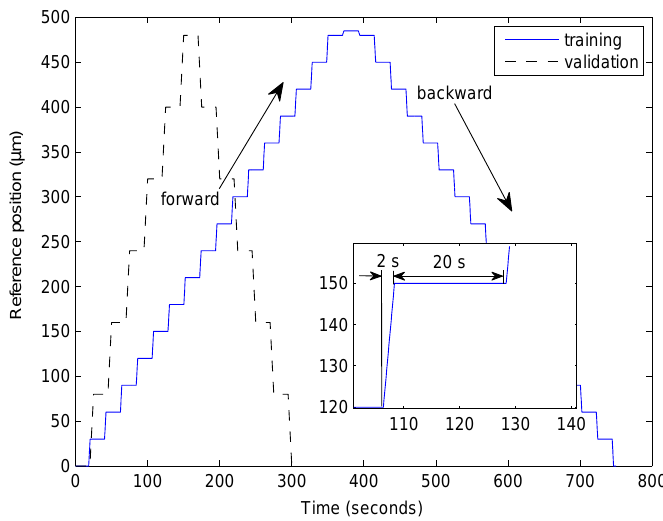
Figure 9. Command trajectories for training and validation in 1